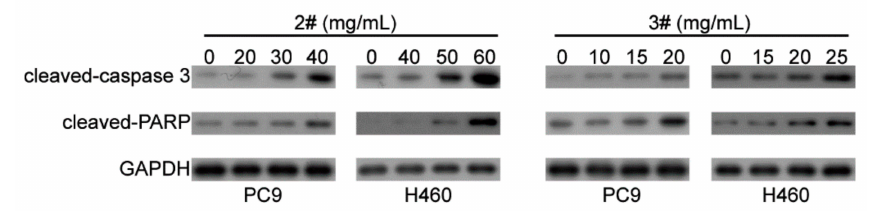
Figure 4. Western blot analysis of apoptosis-related proteins of PC9 and NCI-H460 cells treated with different fractions of F. luteovirens at different concentrations.